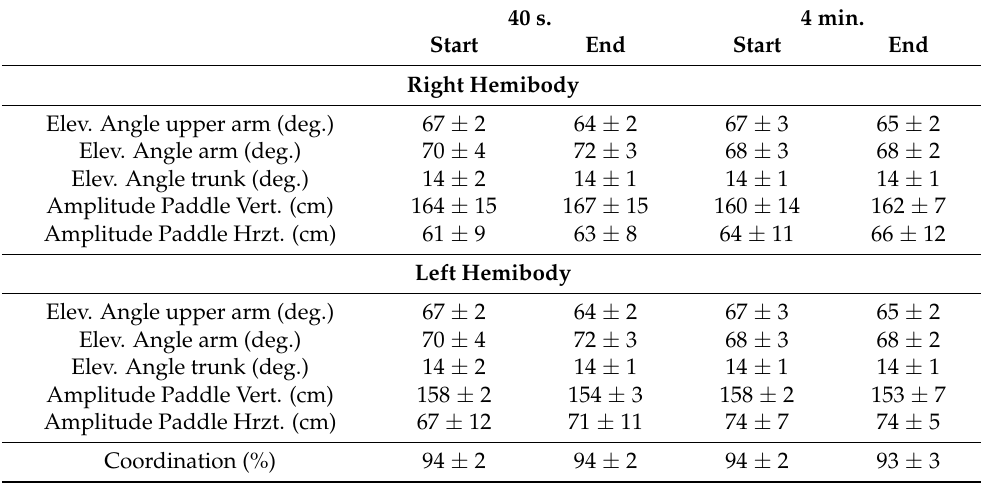
Table 1. Mean and standard deviation across subjects of the main kinematic parameters for the 40 s and 4 min conditions. 40 s. 4